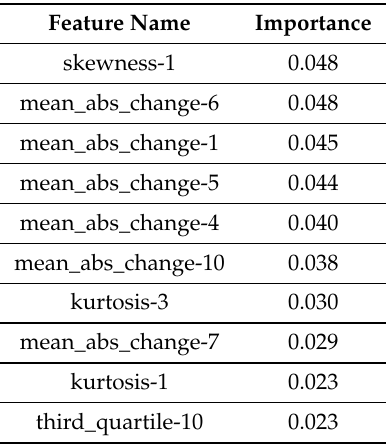
Table 3. Feature importance for the top 10 features extracted from the best RF model trained by the predictive analytics